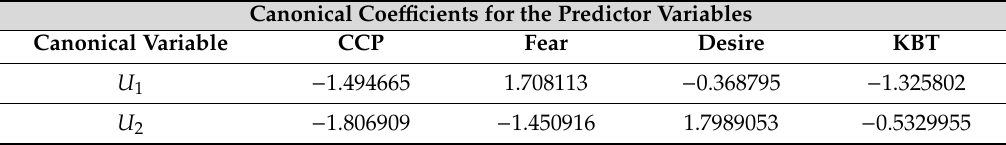
Table 3. The canonical coe ffi cients for CCP, fear, desire, and KBT in terms of U 1 , U 2 .